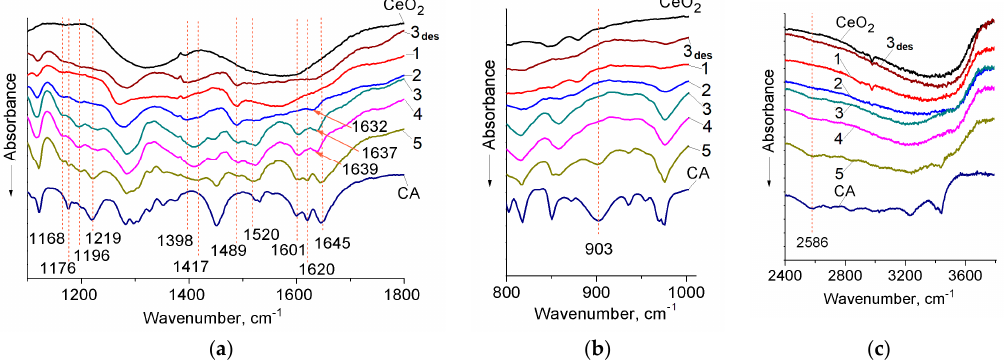
Figure 1. Fourier transform–infrared (FT–IR) spectra of pure caffeic acid (C А ), samples of CA/CeO 2 in various concentrations (1–0.1; 2–0.3; 3–0.6; 4–0.9; 5–1.2 mmol/g) and CA/CeO 2 (0.6 mmol/g), after desorption—3 des .